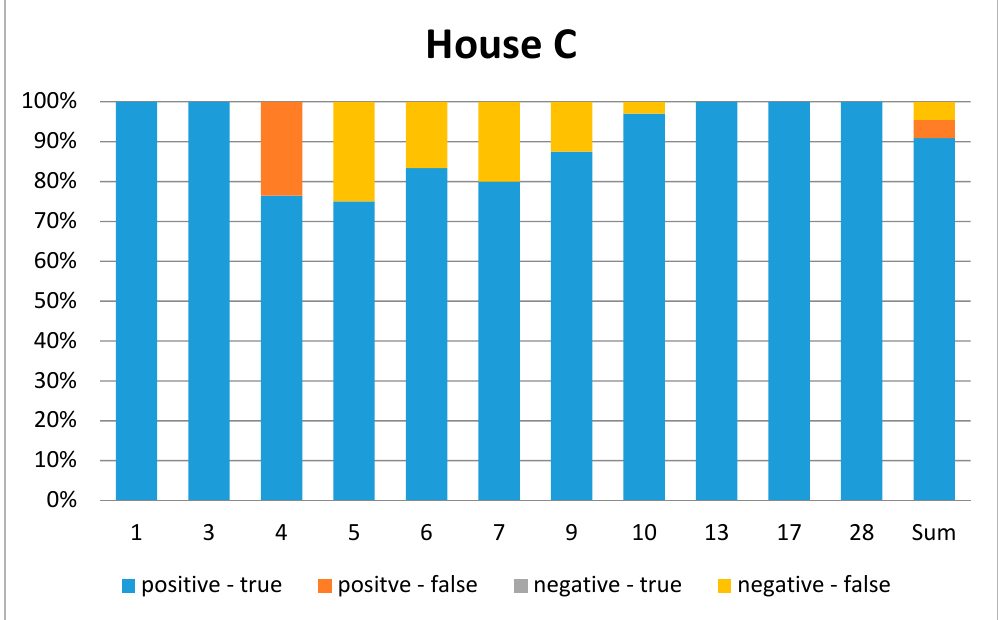
Figure 8. Graphical representation of the confusion matrix for House B. Each bar represents one ADL. (1 = leave house, 4 = toilet usage, 5 = shower, 6 = brush teeth, 10 = sleep, 13 = prepare breakfast, 40 = play piano). The last bar represents the overall ADL.